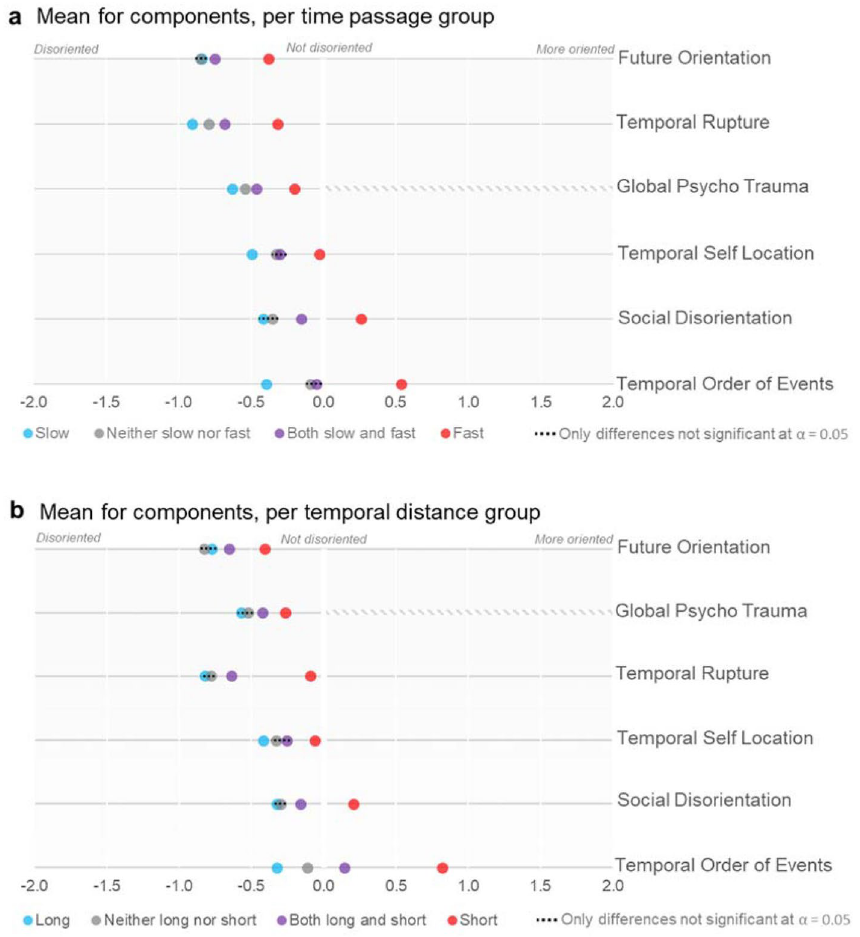
Figure 2. Mean components per time judgements